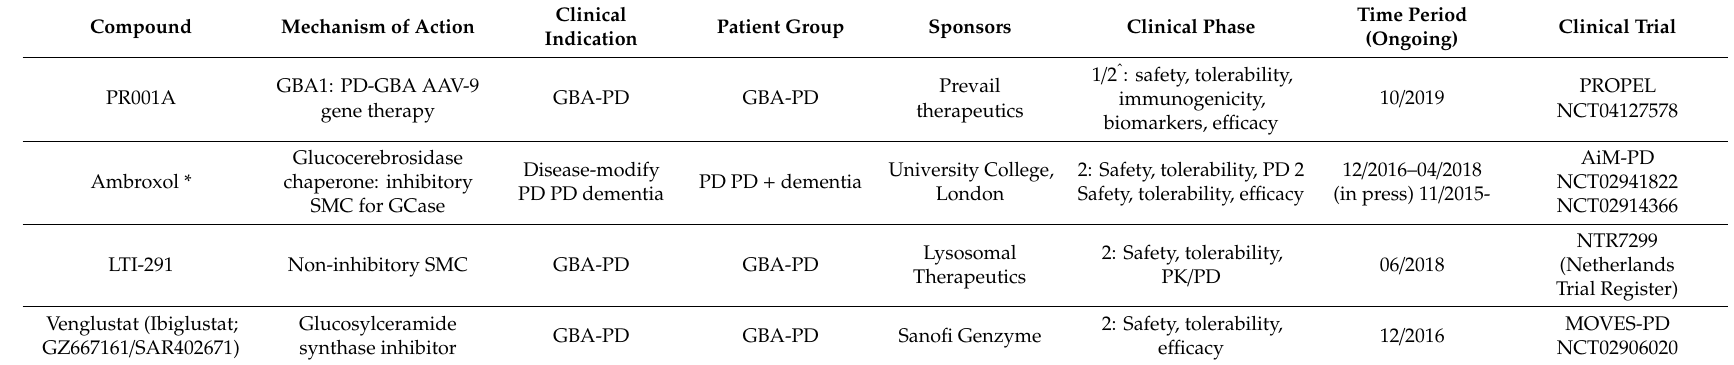
Table 3 Glucocerebrosidase (GBA)-based disease-modifying treatment strategies and their current progress in clinical trials. * Repurposed drugs, ˆ first in-human study administering PR001A (gene therapy) in GBA-PD patients with a sham procedure as control; PK = pharmacokinetics, PD = pharmacodynamics; Clinical phases: 1 = Phase 1, clinical trials that focus on drug safety typically conducted with healthy volunteers to determine the drug’s pharmacokinetics and most frequent and serious adverse events; Phase 2, clinical trials that focus on the drug’s e ff ectiveness in patients populations while continuing to study its safety and short-term adverse